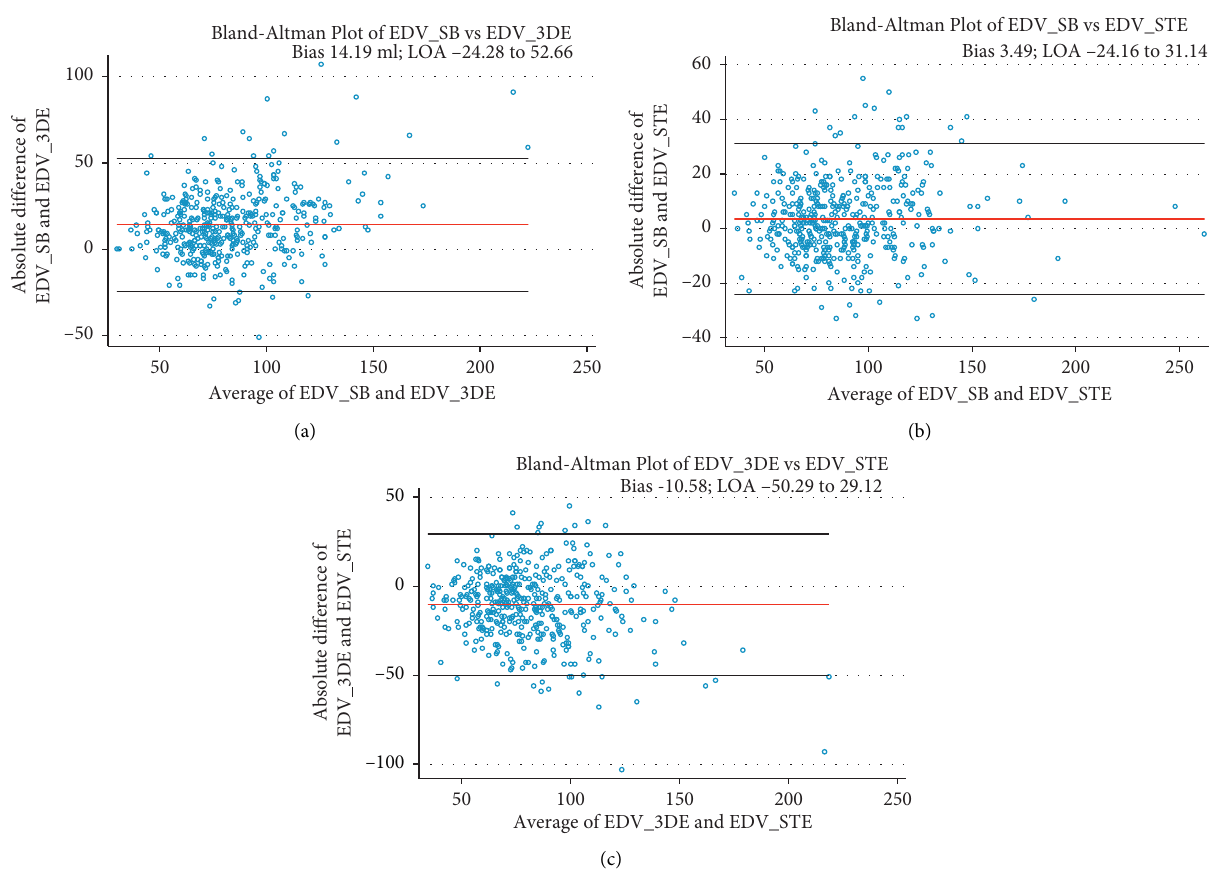
Figure 5: Bland–Altman plots for the comparisons between (a) EDV_SB and EDV_3DE, (b) EDV_SB and EDV_STE, and (c) EDV_3DE and EDV_STE. Bias: 14.19ml (95% CI 12.38–16.00); bias: 3.49ml (95% CI 2.23–4.75); and Bias: 10.58ml (95% CI -12.46 to -8.71),